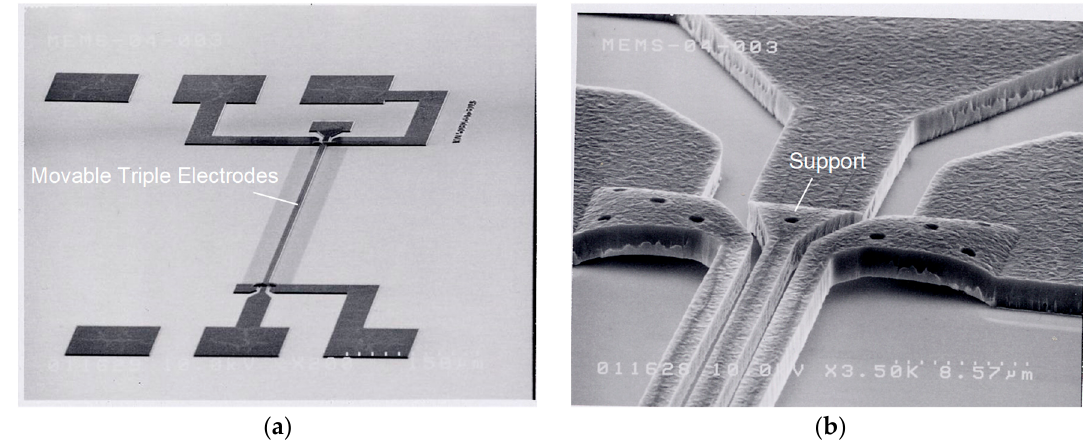
Figure 6. SEM images of fabricated switches: ( a ) overview; ( b ) close-up of support area.